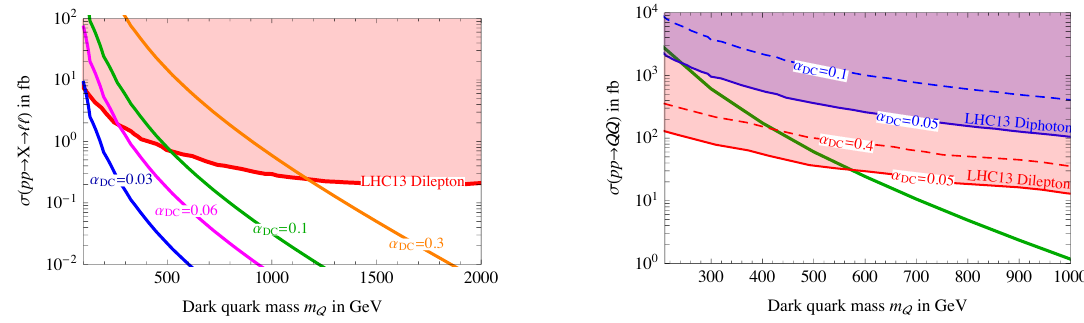
Figure 8 . Left: ATLAS bounds on the cross section for the direct production of a spin 1 resonance decaying into leptons ( (cid:22) und e) [60]. Right: ATLAS bounds on the dark quarks pair production cross section [60]. They are derived assuming that 1 = 3 of the produced dark quarks form spin 1 (cid:24) bound states and the others spin 0 bound